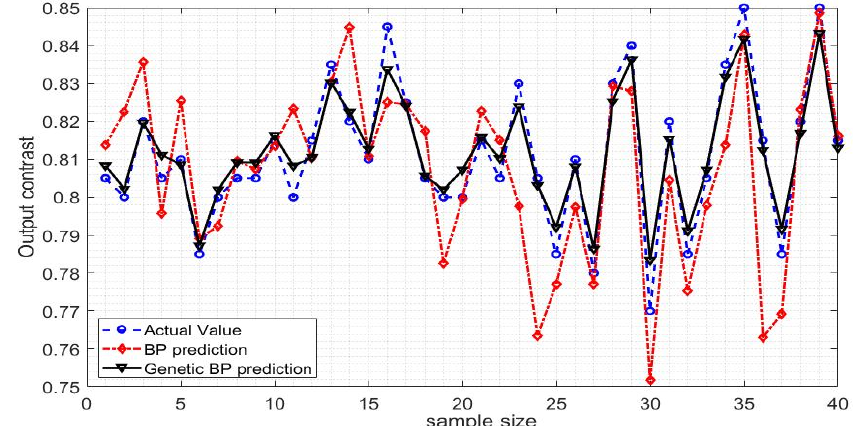
Figure 5. Comparison diagram of BP and GABP fitting accuracy.